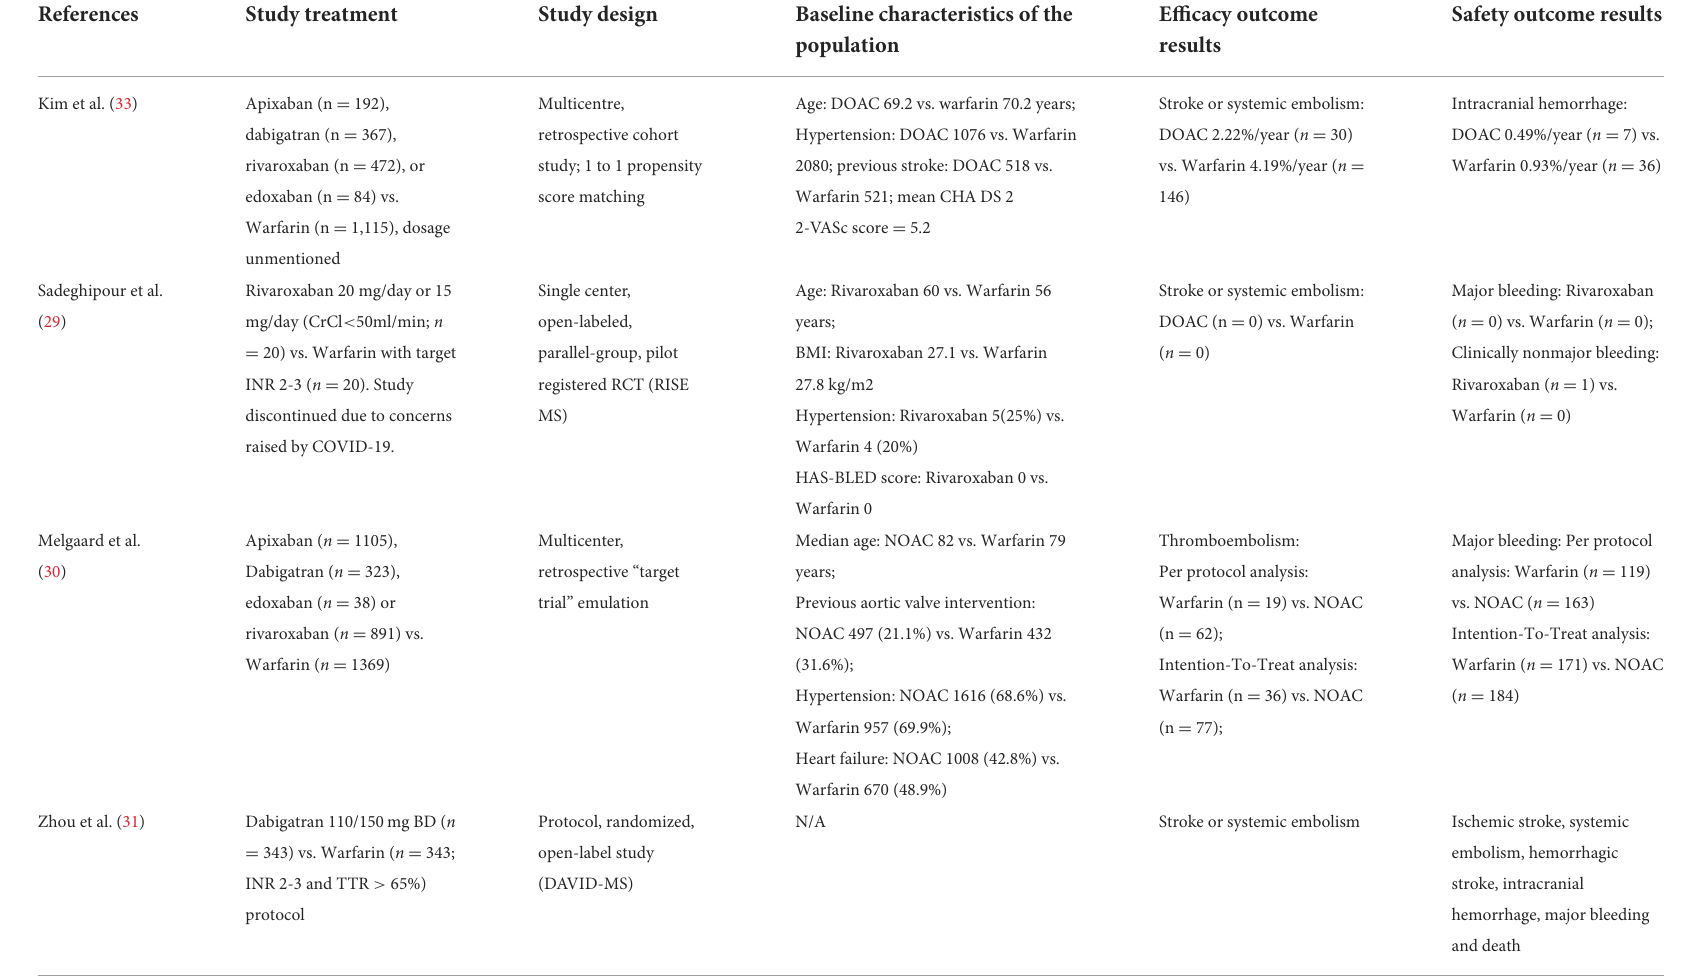
TABLE 1 The baseline data of the included studies in this